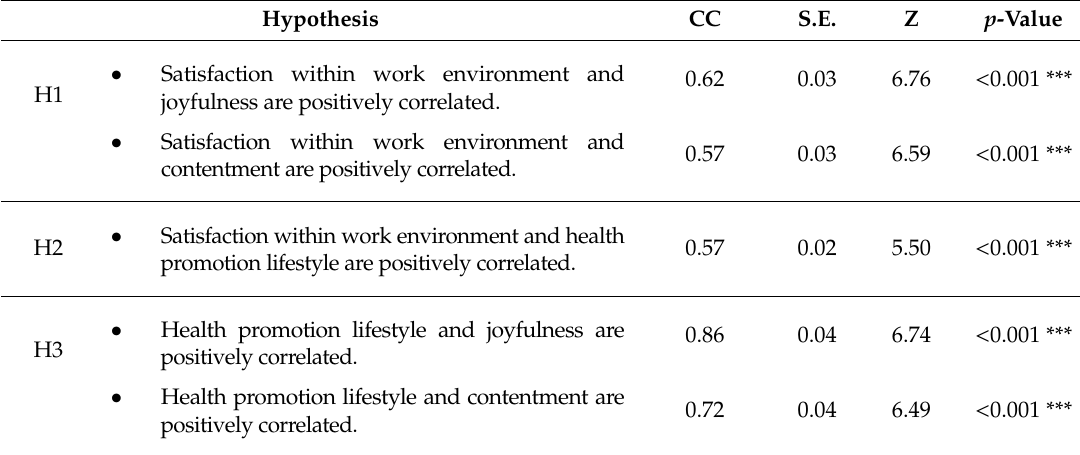
Table 3. Correlation Coe ffi cient of the Structural Relationships for the WHS